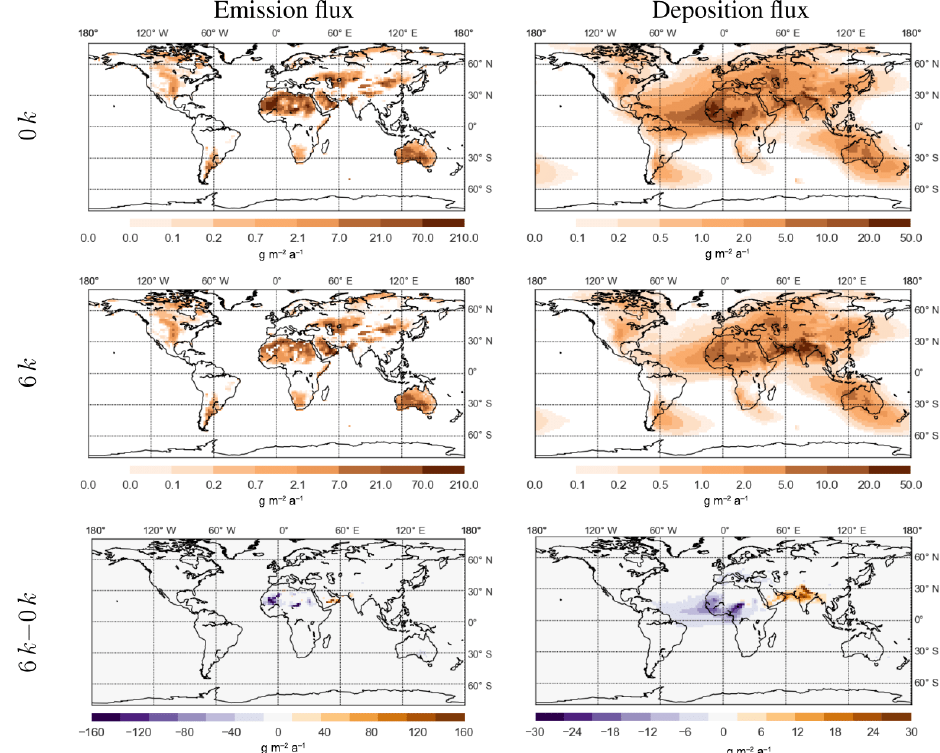
Figure 2. Simulated global annual mean dust emission flux (left) and dust deposition flux (right) for 0 k , 6 k and for the difference 6 k –0 k .